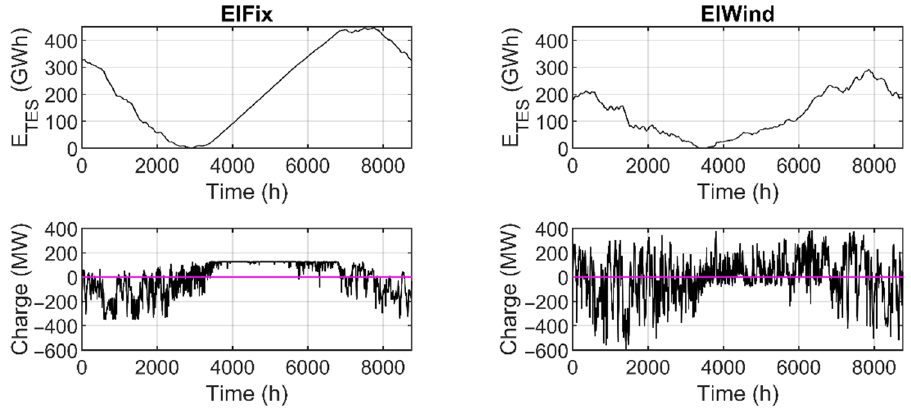
Figure 11. State of charge of TES and charge/discharge rates in cases ElFix and ElWind.